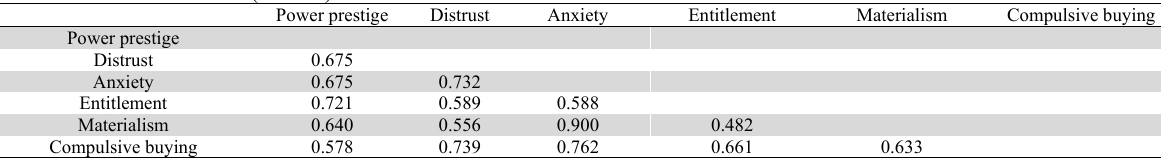
Heterotrait-Monotrait ratio(HTMT) Power prestige Distrust Anxiety